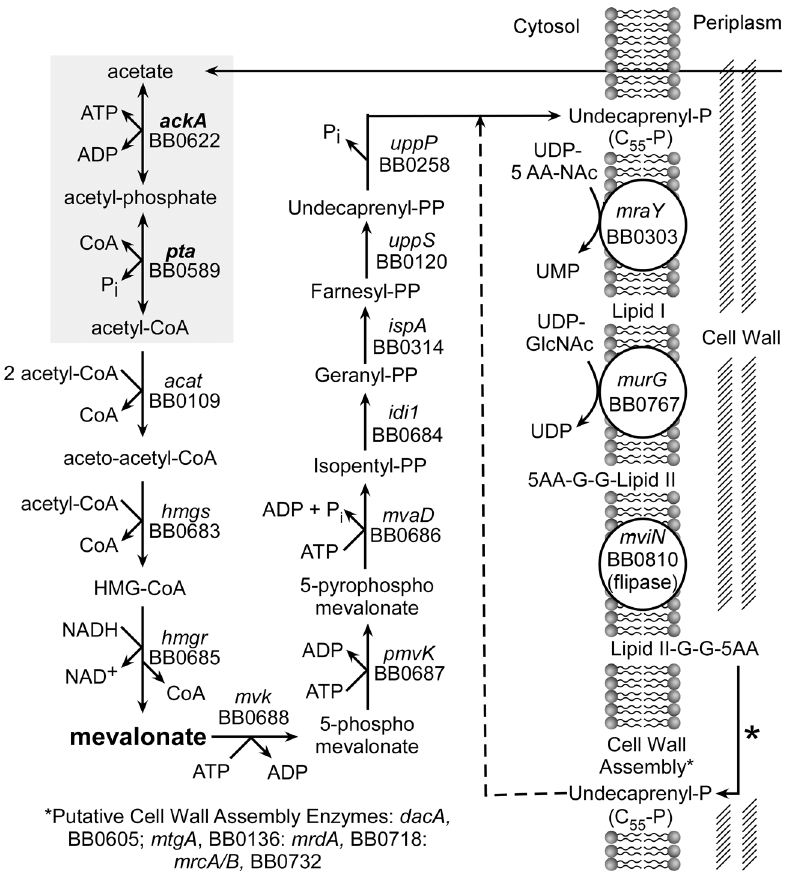
Fig 1. The putative pathway for the synthesis of undecaprenyl-P (C 55 -P) in B . burgdorferi . A schematic diagram showing the proposed pathway for the conversion of acetate to C 55 -P and its role in cell wall biogenesis. Mevalonate, the intermediate that was added to the plating BSK II to isolate mutants, is highlighted. The genes ackA and pta are highlighted by